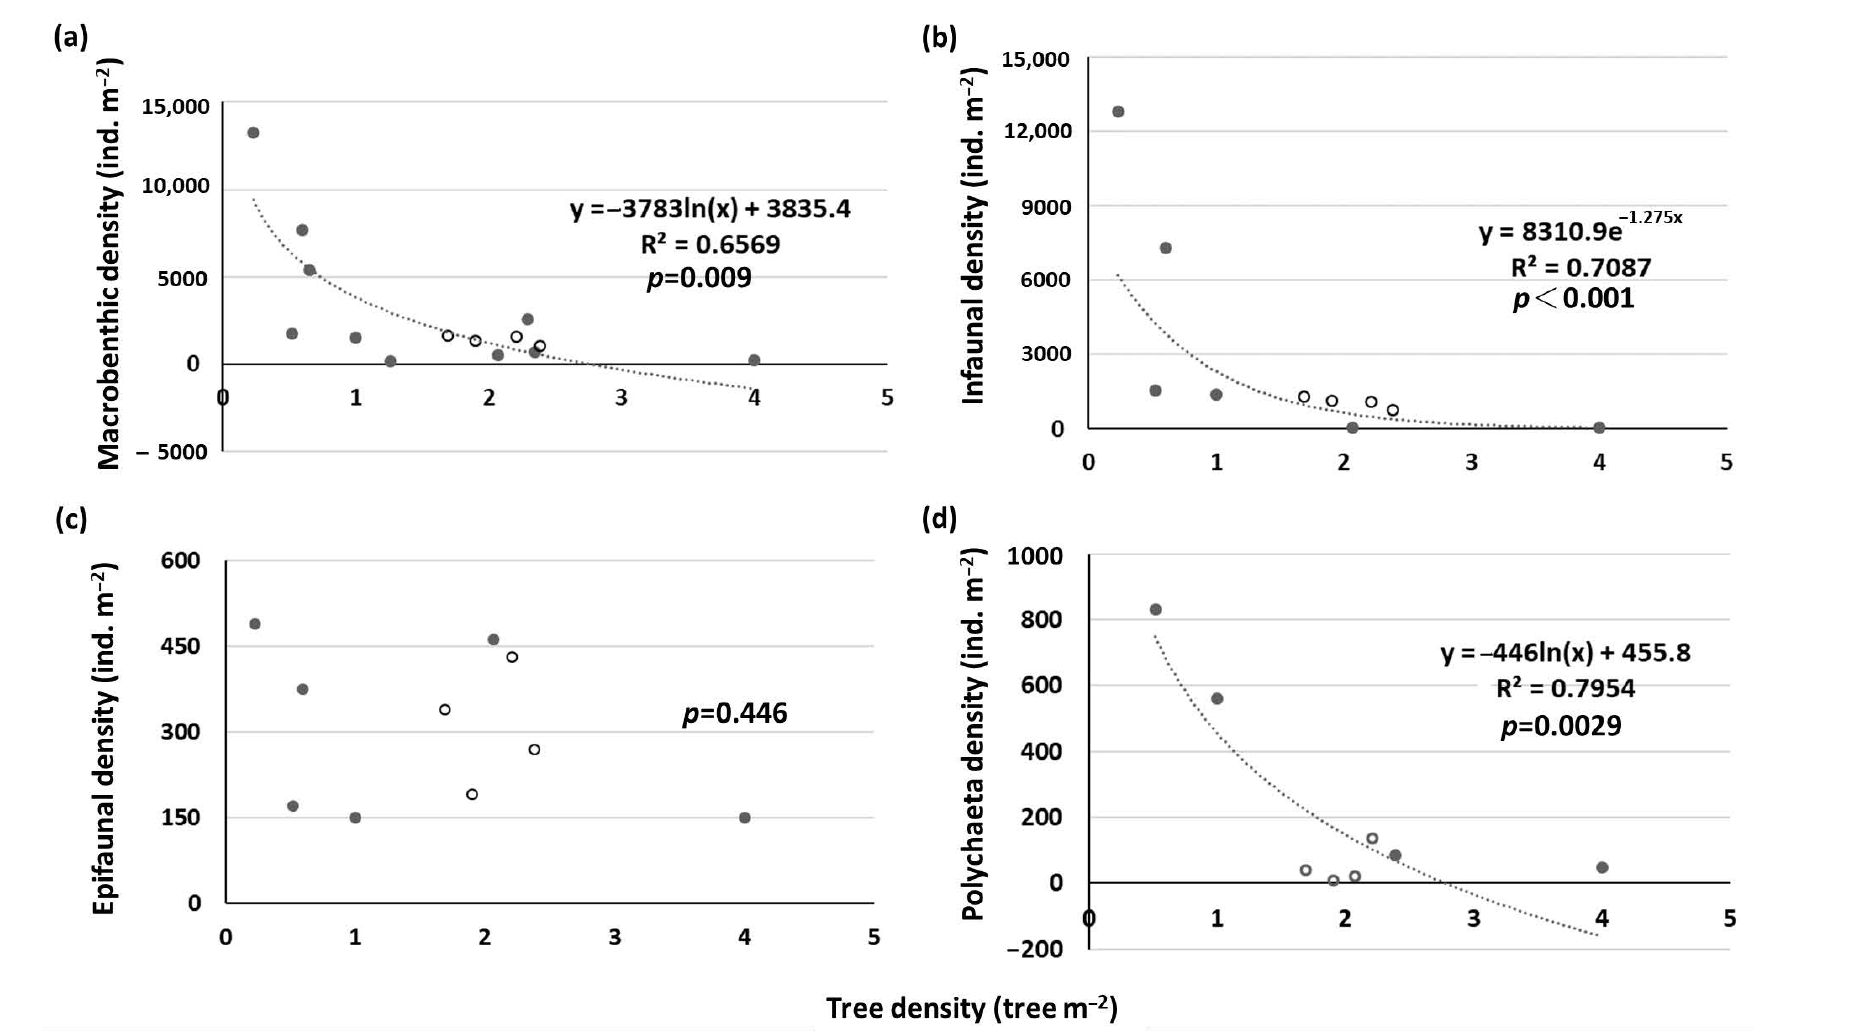
Figure 7. Relationships between the densities of ( a ) macrobenthos, ( b ) infauna, ( c ) epifauna, and ( d ) polychaetes and the tree density of Kandelia obovata . White dots: this study; black dots: prior